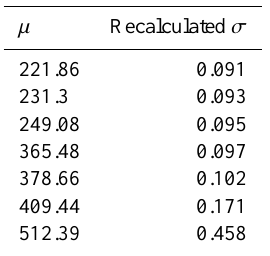
Figure 3. CSA temperature profile at stable power levels (a) 11MWTh and (b) 18MWTh.